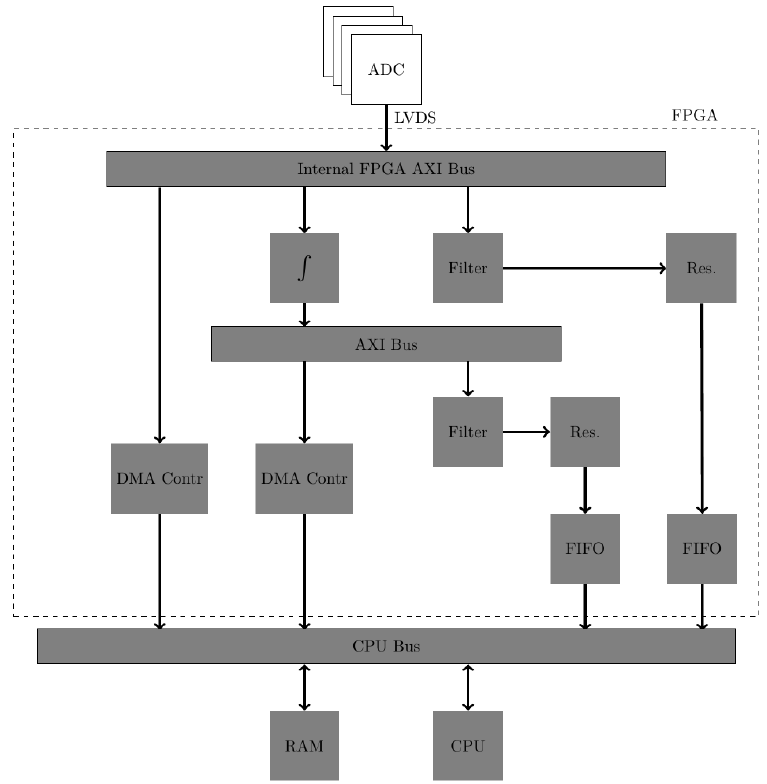
Figure 2. The FPGA